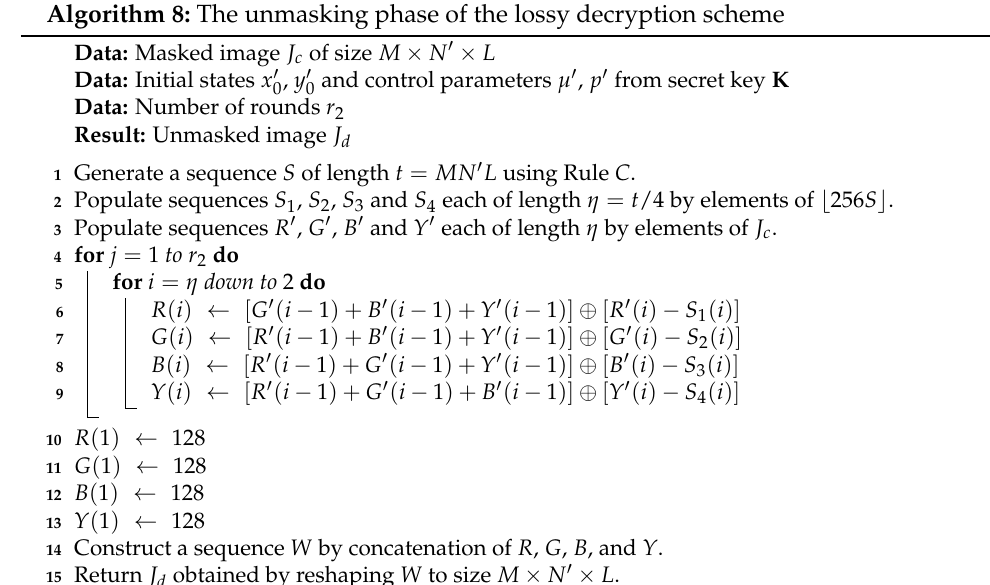
Algorithm 8: The unmasking phase of the lossy decryption